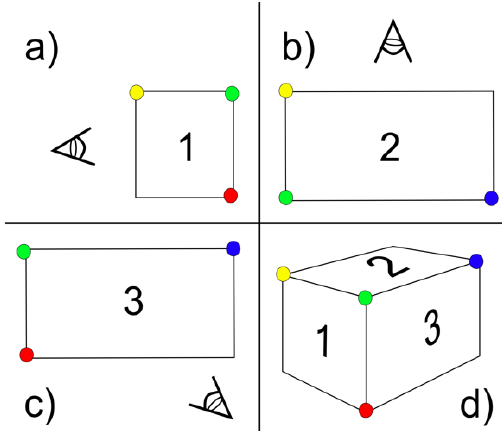
Figure 13. A simplified illustration of the principle of Structure-from-Motion Multiview Stereo photogrammetry. Common points at the corners of a rectangular prism seen from various angles are used to reconstruct a three-dimensional representation of the object. ( a ) the side; ( b ) the top; ( c ) the front; ( d ) the reconstructed rectangular prism. In reality, hundreds to thousands of key points (uniquely identified points) per photograph are needed with hundreds to thousands of matches between photographs to reconstruct a surface in 3D.